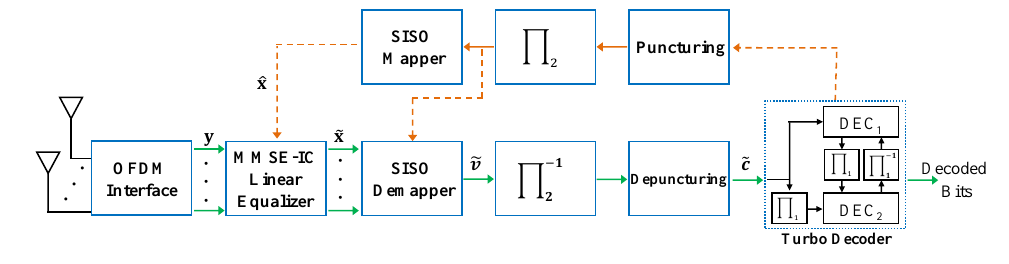
Figure 1. Block diagram of the MIMO-OFDM turbo